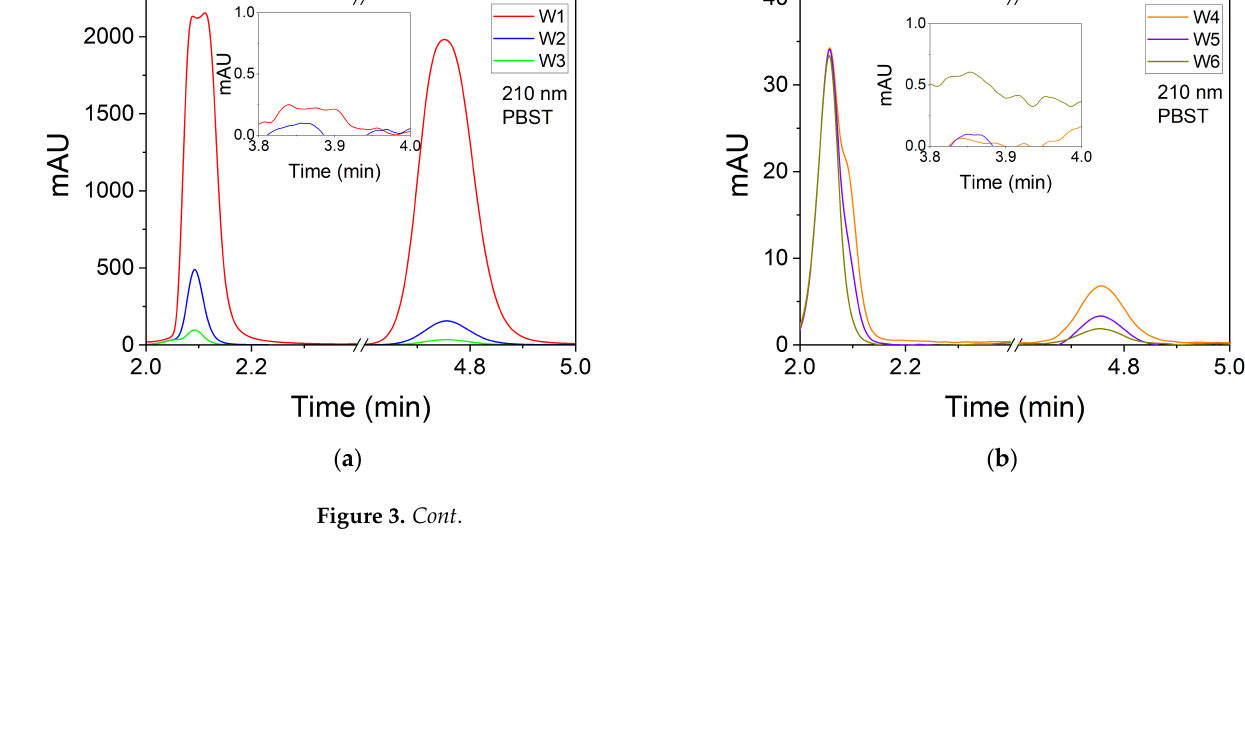
Figure 2. Chromatograms (mAU = mili OD at 210 nm) of standard solutions of the compounds used for the storage of holograms in the hydrogel matrices. ( a ) AAm and MBA; ( b ) EY, TEA, TEMED and